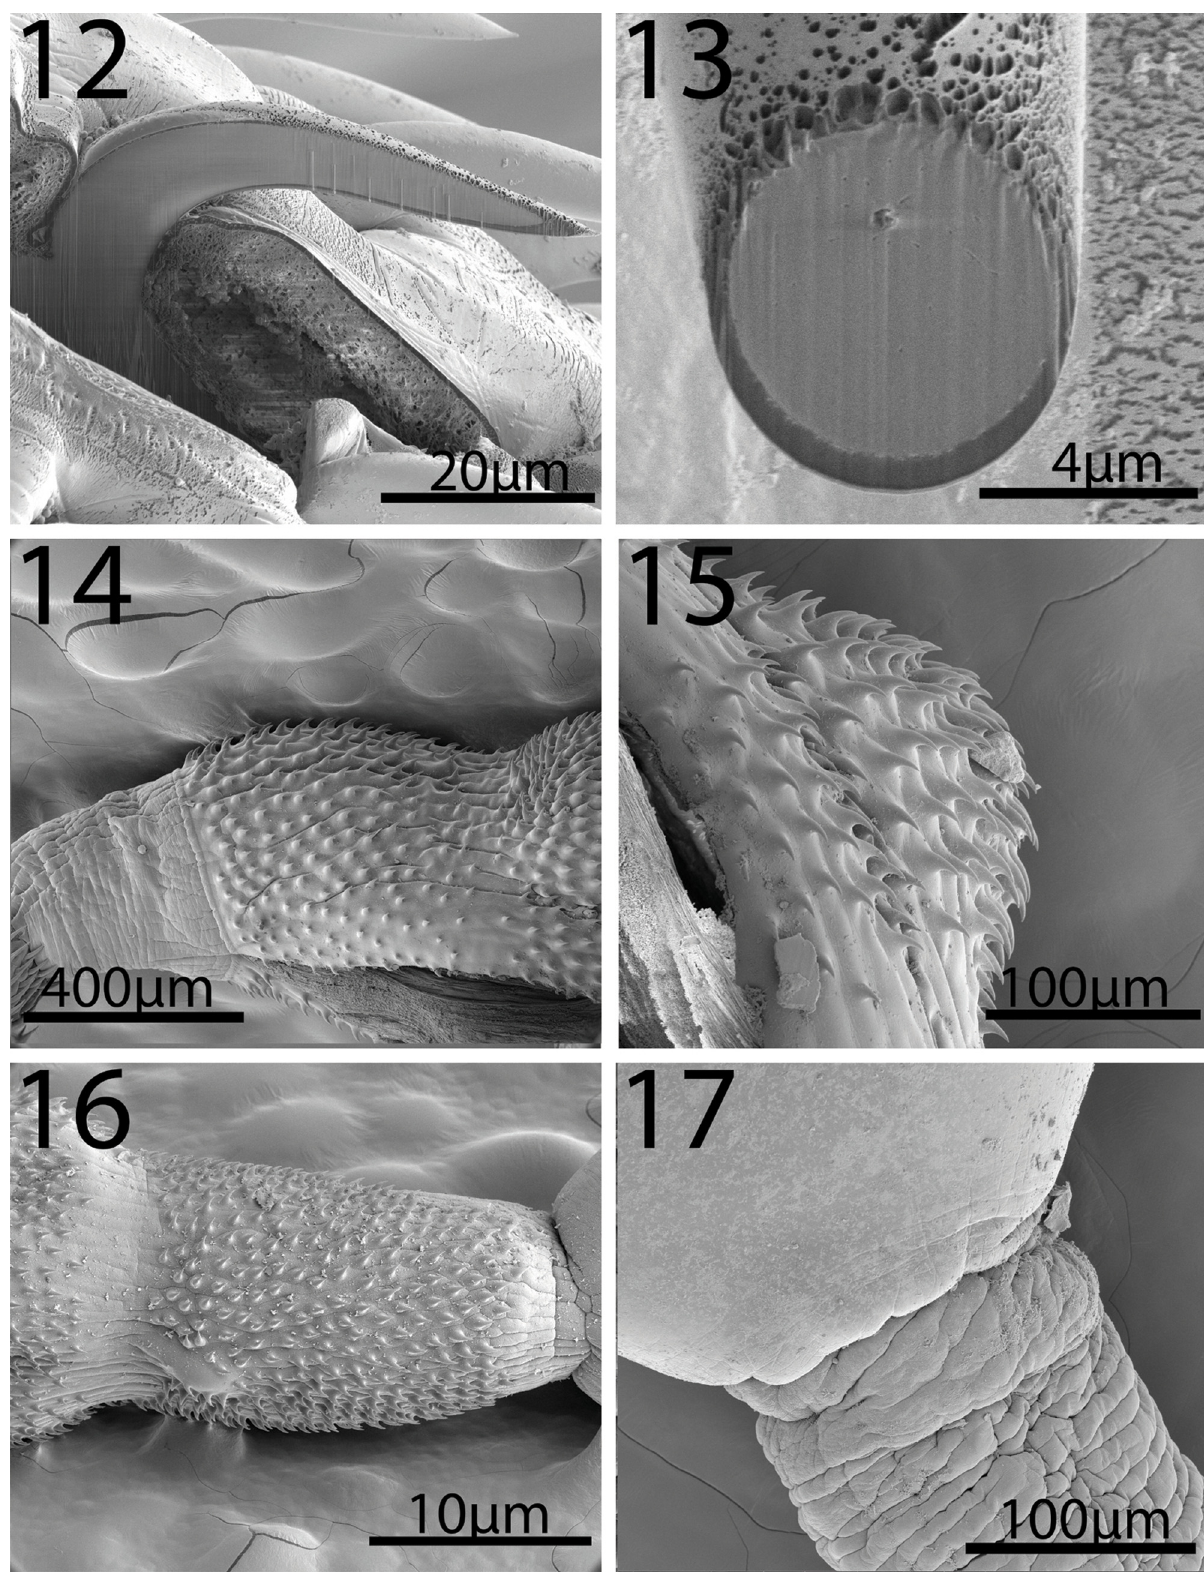
Figures 12-17. SEM of cystacanths of Neoandracantha peruensis from ghost crabs, Ocypode gaudichaudii , from the Paci fi c Ocean off Peru. 12 – 13. Lateral and cross-sections of gallium cut probosacis hooks showing their solid core and thin cortical layer. 14. The anterior fi eld of spines of the foretrunk. 15. The middle fi eld of spines of enlarged middle area of the foretrunk. 16. The posterior fi eld of spines of the foretrunk near the junction with the midtrunk. 17. The unarmed junction of the midtrunk and